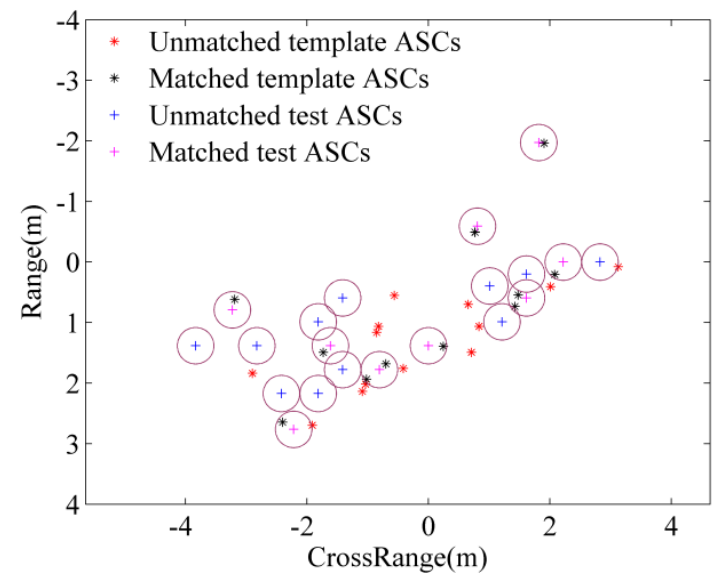
Figure 3. The neighbor matching results between the test and template ASC sets from BMP2 at the radius of 0.3 m. Remote Sens. 2018 , 10 , x FOR PEER REVIEW